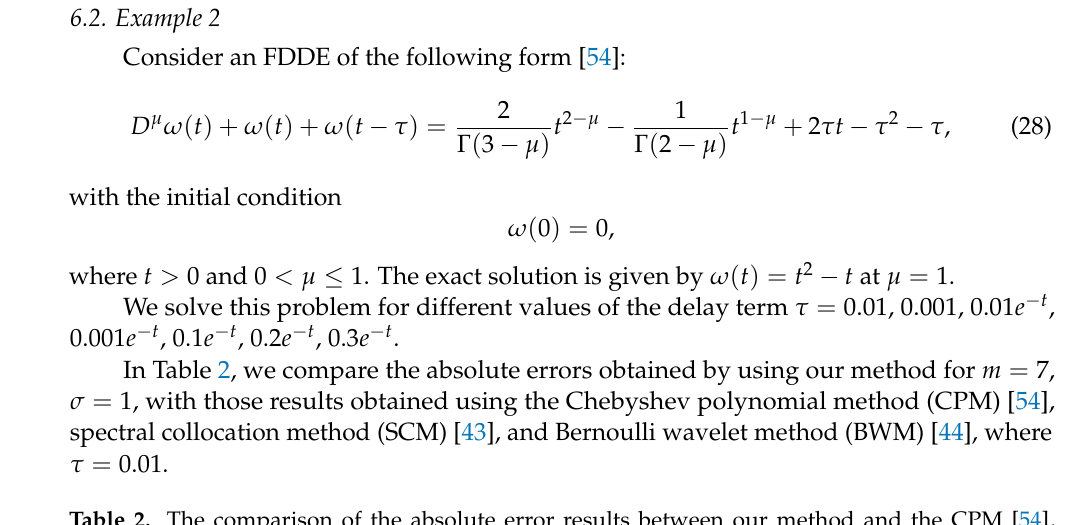
Table 2. The comparison of the absolute error results between our method and the CPM [54], SCM [43], and BWM [44] for τ =